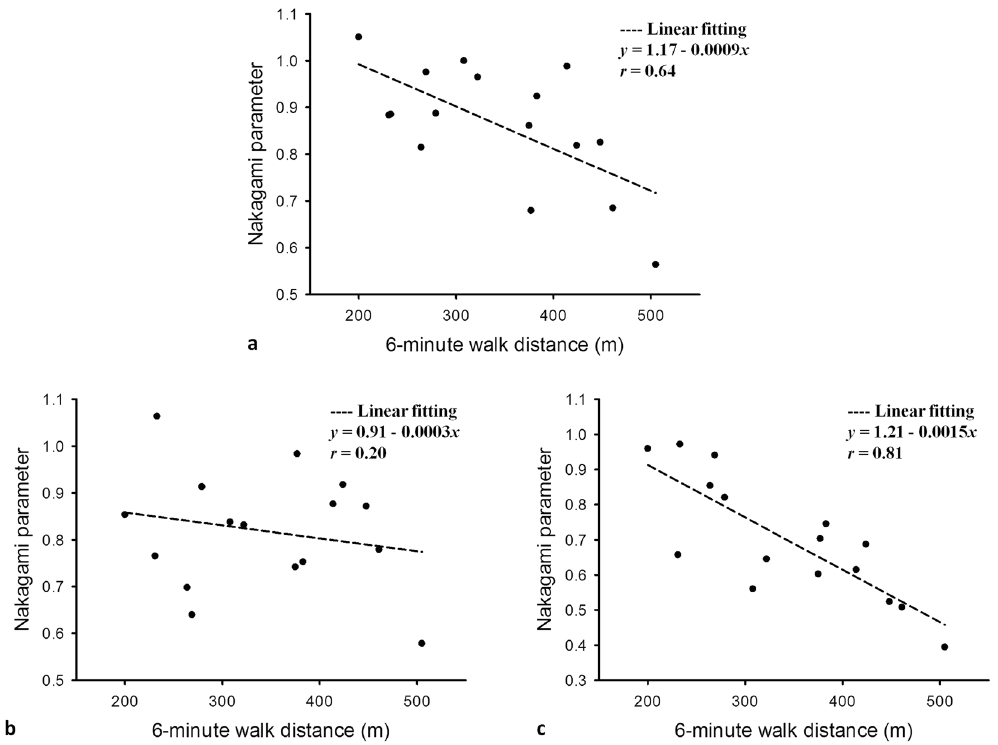
Figure 5. Correlations between the Nakagami parameters and 6MWT results in ambulatory patients with DMD (age > 5 years). Data are expressed as the correlation coefficient r and were obtained using a linear curve fitting model y = y0 + ax. The Nakagami parameters in the rectus femoris and gastrocnemius muscles exhibited an increase with shorter walking distances. ( a ) Rectus femoris ( r = 0.64); ( b ) tibialis anterior; and ( c ) gastrocnemius ( r =